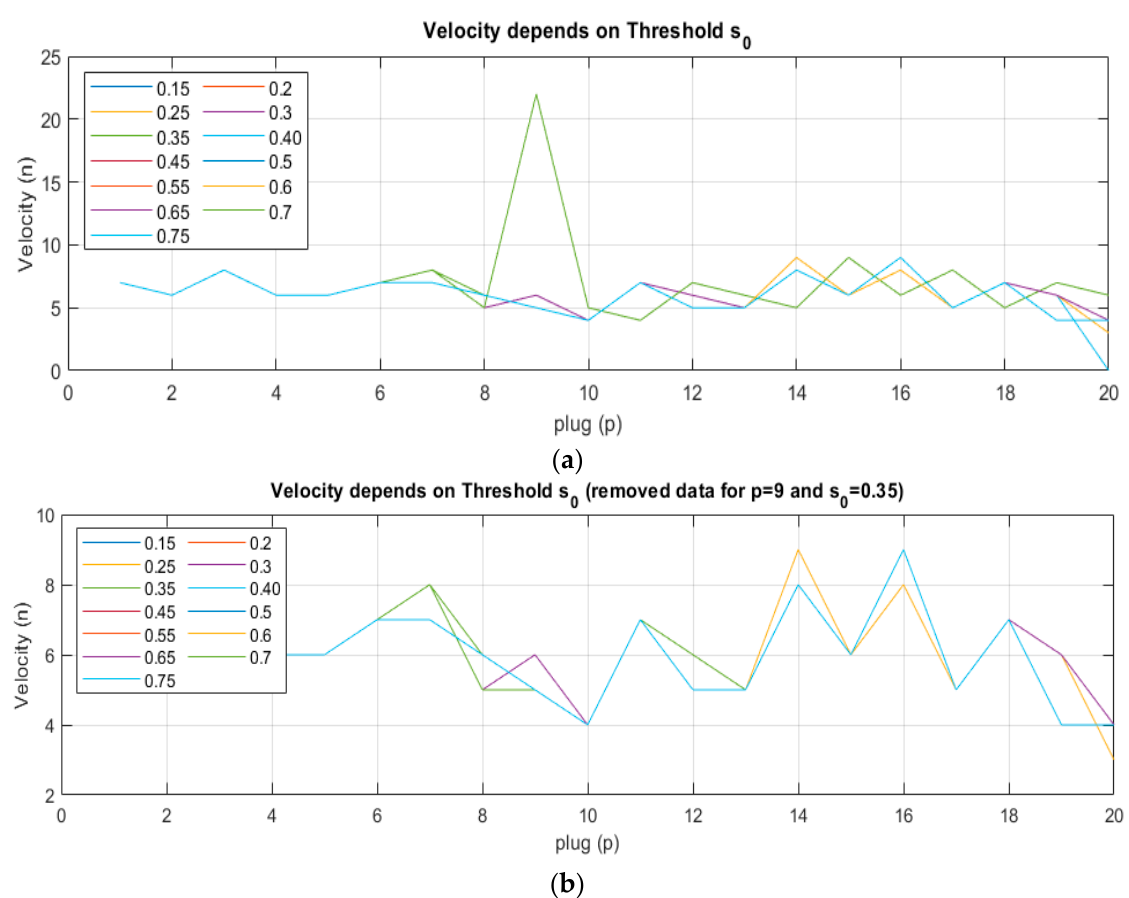
Figure 8. Material velocity estimation chart in relation to the parameter s 0 for each plug. The different colors represent parameter s 0 : ( a ) Full data, ( b ) removed data for s 0 = 0.35 m, and plug number 9.